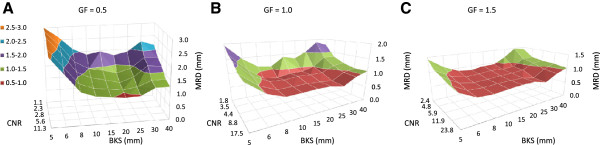
Mean residual displacement (MRD) for varying contrast-to-noise (CNR) levels and B-spline knot spacings (BKSs). The image noise varied from 20–200 HU (1 SD) in combination with (A) GF = 0.5 (Phantom V-IX), (B) GF = 1.0 (Reference phantom and phantom I-IV), and (C) GF = 1.5 (Phantom X-XIV). Phantoms according to Table 1. GF = grey value factor. Note that the overall MRD decreased with increasing GF and note the spacing of the BKS-axis.